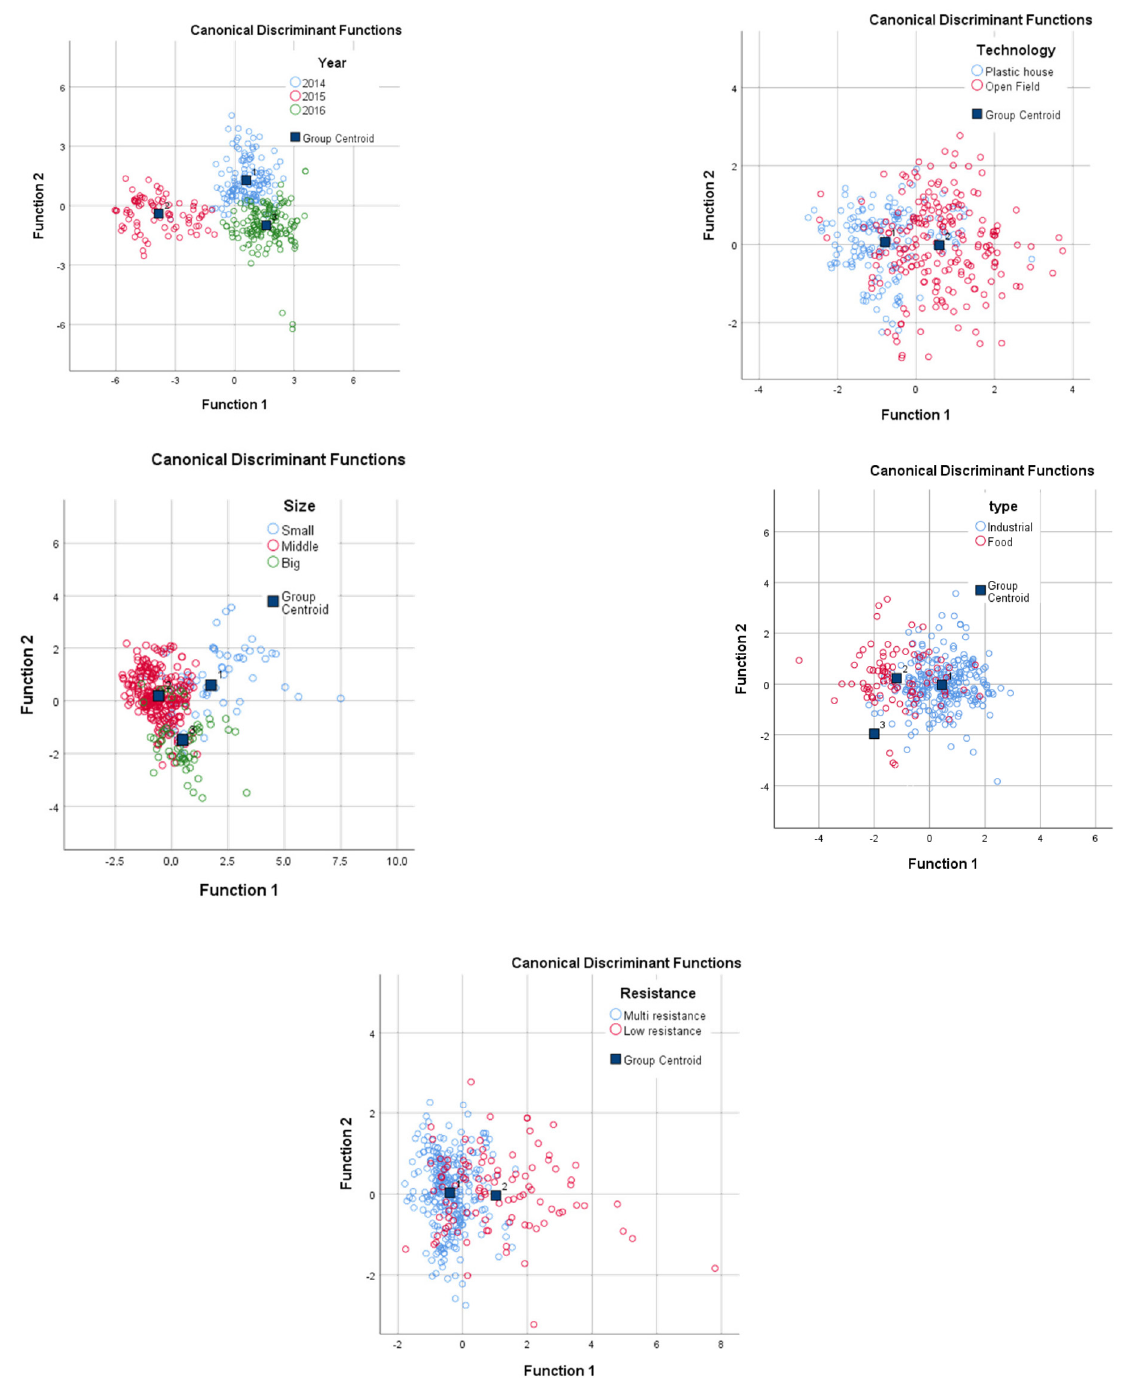
Figure 1. Discriminant analysis of different season, field technology, size, type, and resistance data of tomato samples. Discriminant analysis of the results indicated that 95.8% (Year); 78.1% (Technology), 77.2% (Fruit size), 77.7% (Type), 80.3% (Resistance) of original grouped cases were correctly